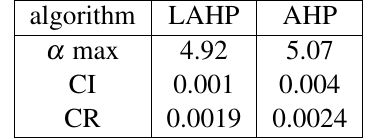
Table 1 Comparison of consistency